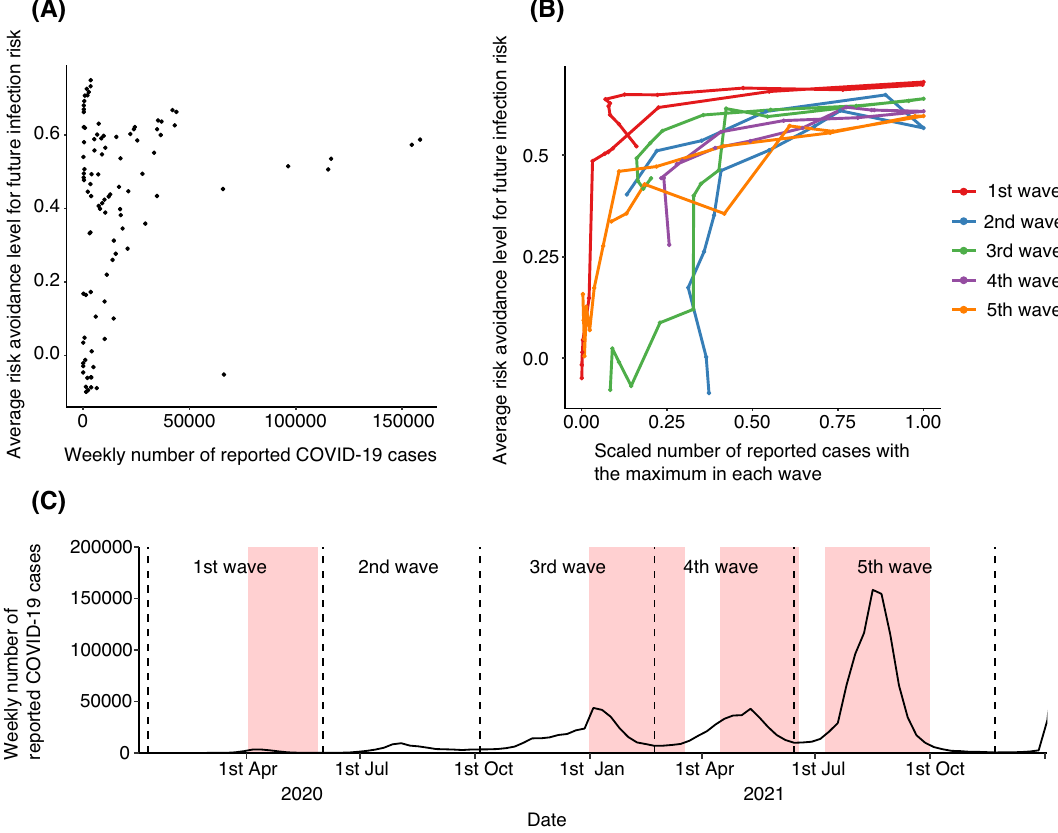
Figure 3. Human behavioural response against COVID-19 with the number of reported cases. ( A ) Weak correlation relation between the travel avoidance level and the number of reported COVID-19 cases. Vertical axis shows the average travel avoidance level for the travel from 0 to 365 days later. Horizontal axis shows the number of reported COVID-19 cases in all of Japan. ( B ) Stratification of time-series of reported cases by the wave of epidemic improves the correlation with the travel avoidance level. Vertical axis shows the average travel avoidance level for the travel from 0 to 365 days later. Horizontal axis shows the scaled number of reported cases with the maximum number of reported cases in each wave of COVID-19 in all of Japan, which is equal to unity at the peak of each wave. The colours denote the waves of COVID-19 in Japan. ( C ) The definition of waves of COVID-19 in Japan. Filled red colour squares show the timings when the Japanese government declared a state of